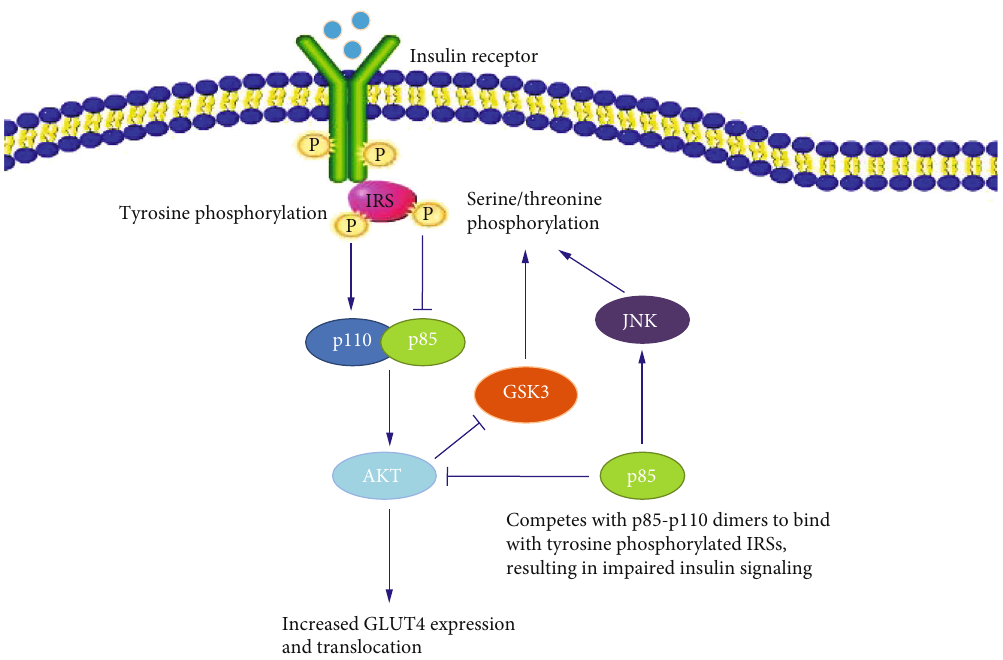
Figure 2: Schematic diagram of potential negative regulation of insulin signal